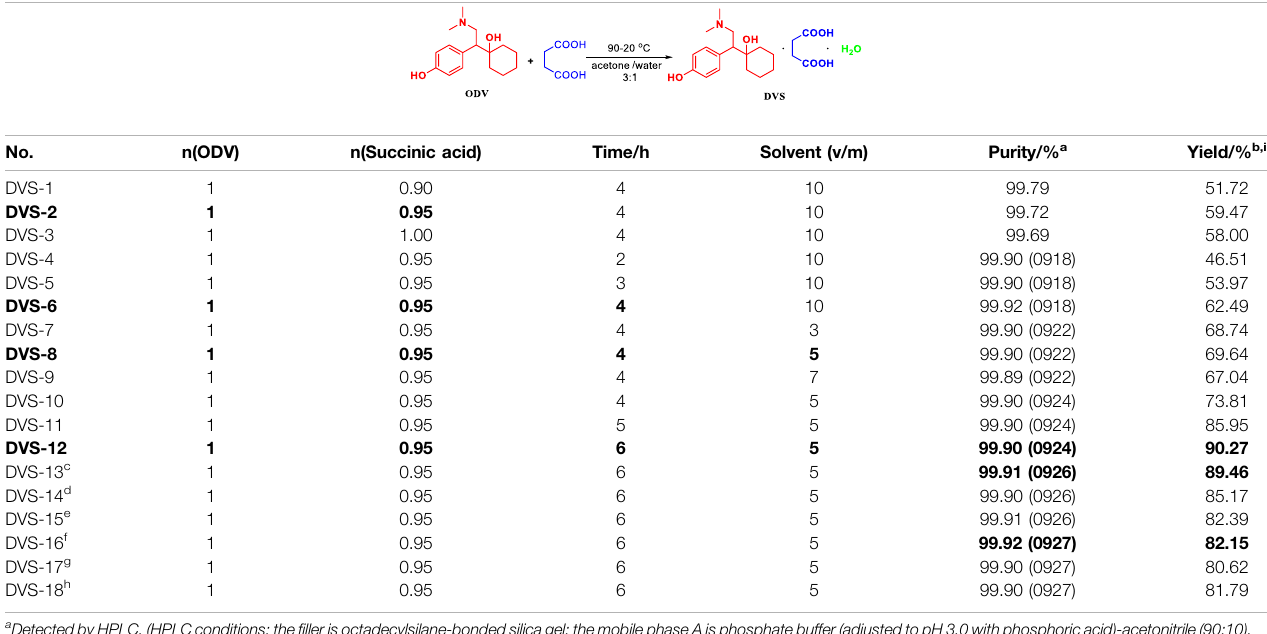
TABLE 5 | Condition optimization of